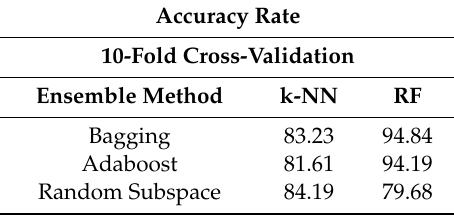
Table 13. Overall performance measure ensemble classifiers for holdout method. Table 12. Overall performance measure ensemble classifiers for 10-fold cross validation